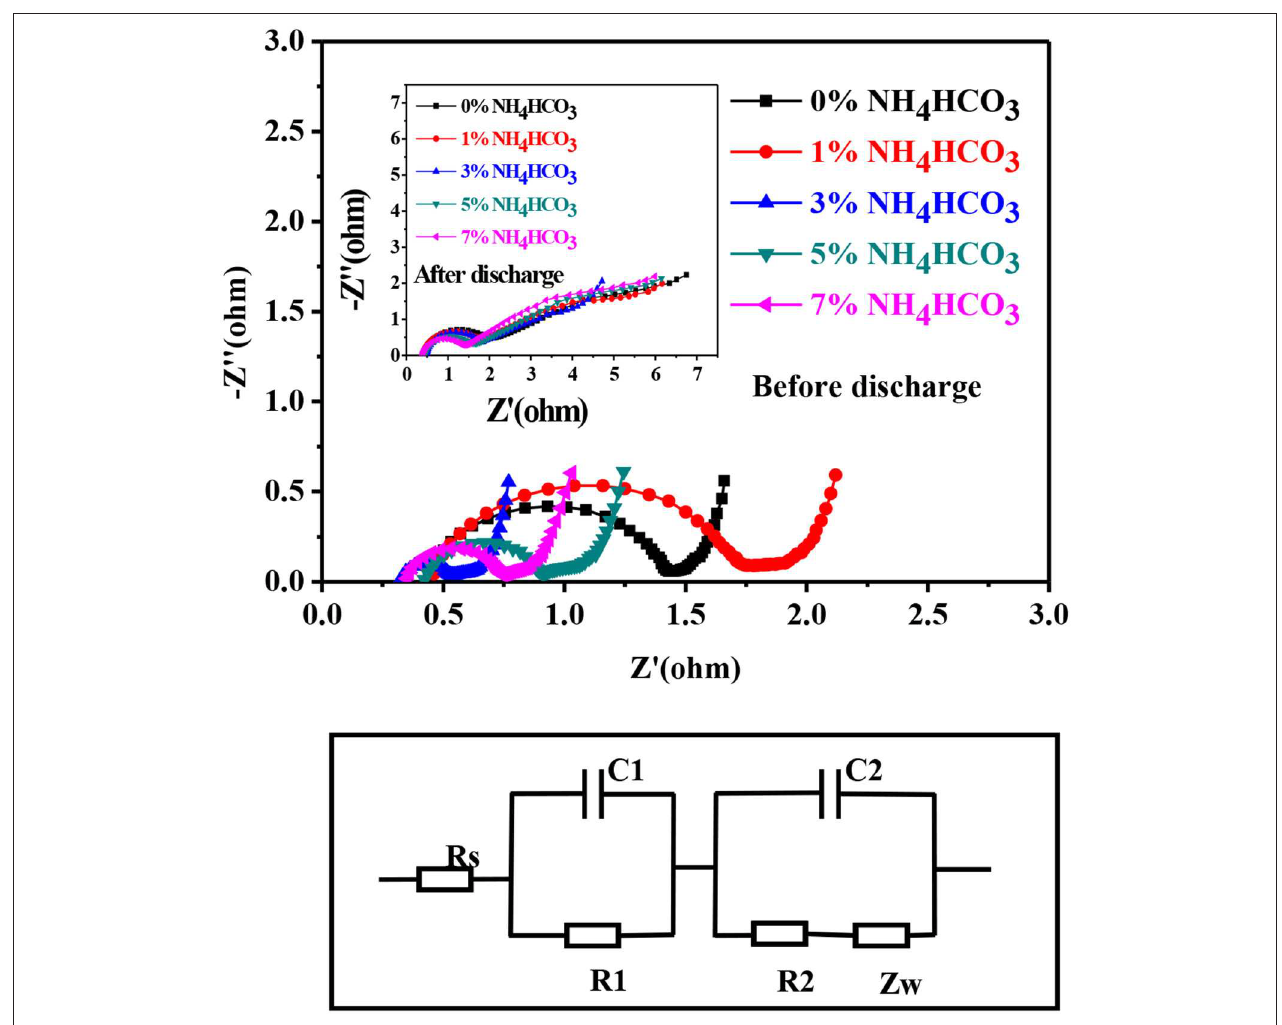
FIGURE 4 | The Nyquist plot of an ER18505M cell before and after discharging at 100mA (above), and the equivalent circuit of the ER18505M cell (below).